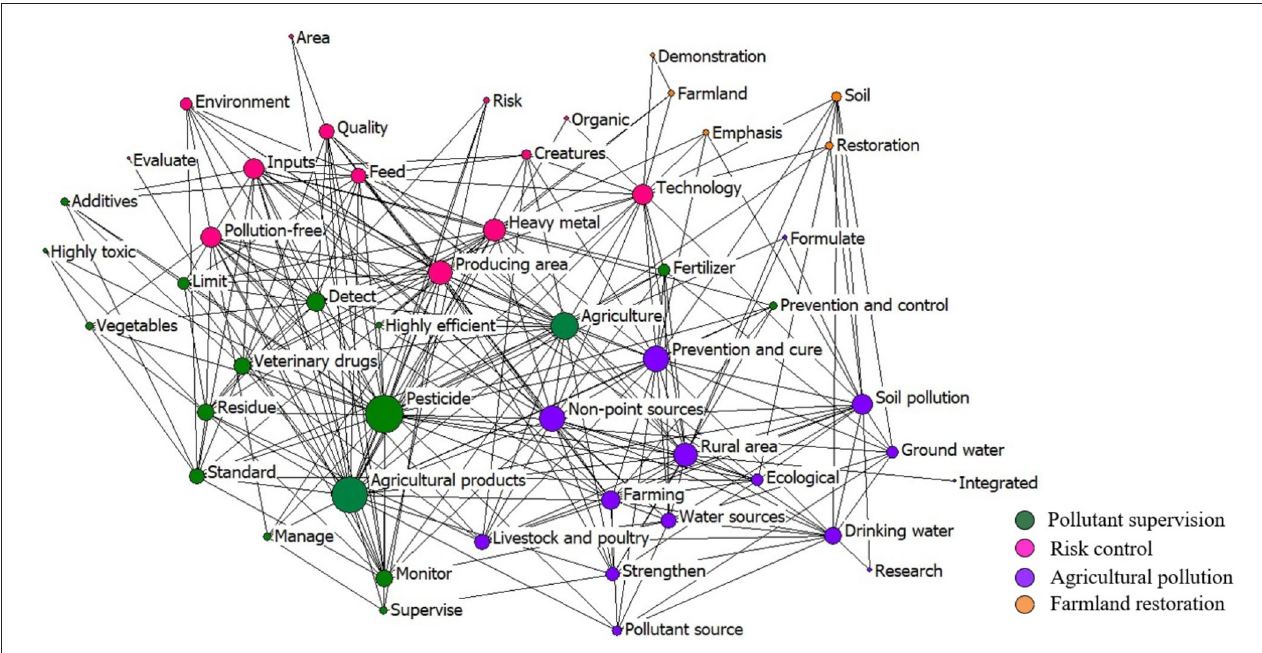
FIGURE 13 | The co-word network of the keywords in the policies in